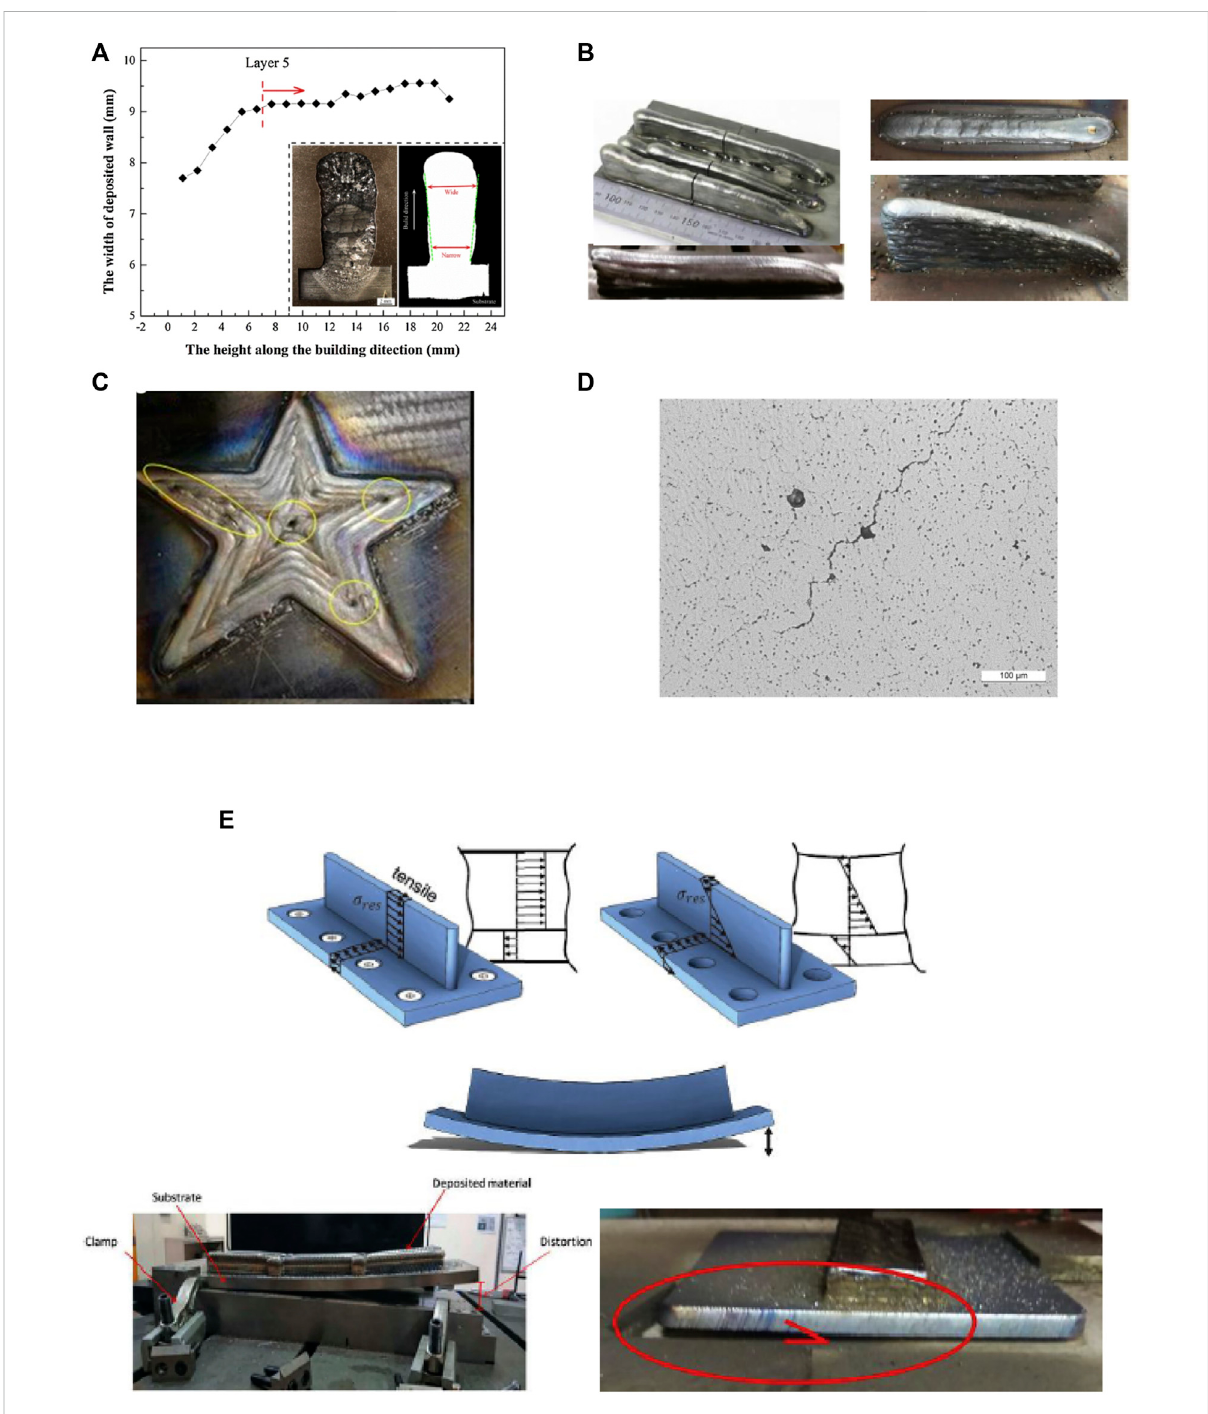
FIGURE 5 Challenges in the WAAM process: (A) Variation in the width of a wall deposited by TIG (Wu, 2017), (B) variation in height at start and end due to difference in heat dissipation, (C) porosities due to poor path planning (Liu et al., 2020), (D) porosity and crack (Gu et al., 2016) (E) distortion (Jafari